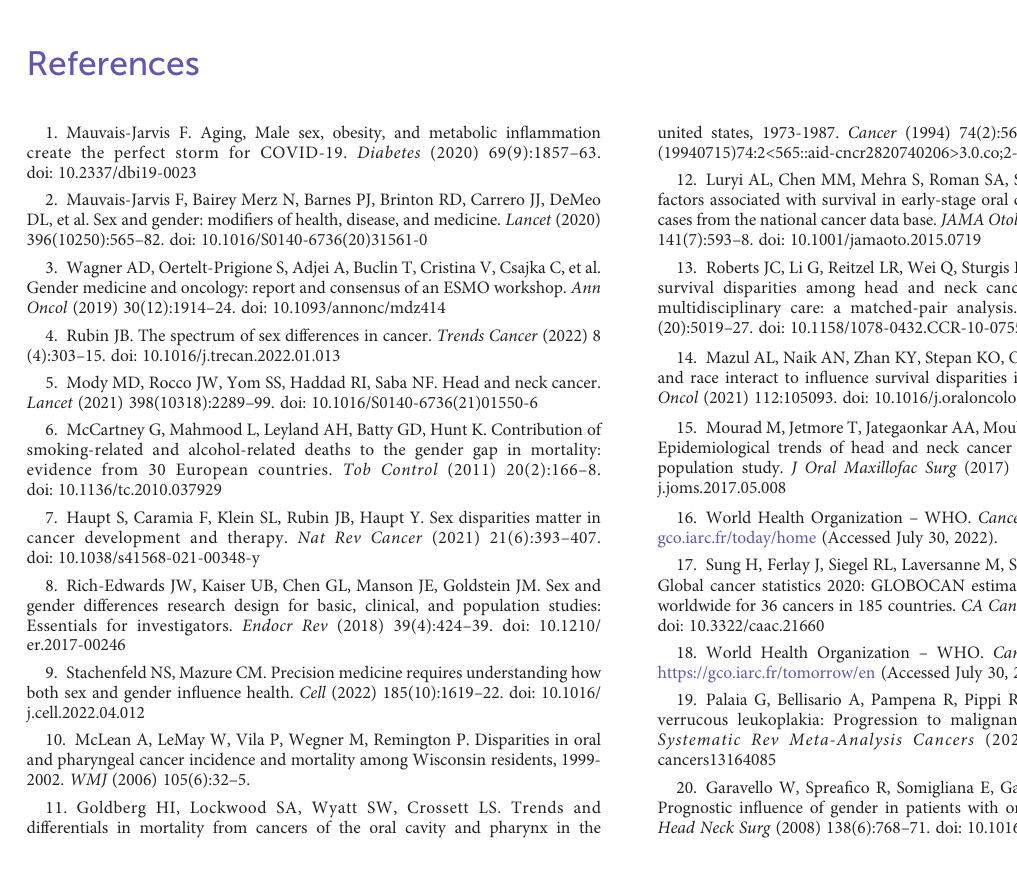
SUPPLEMENTARY TABLE 1 Failure events of the whole patients ’ cohort. SUPPLEMENTARY TABLE 2 Deaths and causes of the whole patients ’ cohort. SUPPLEMENTARY TABLE 3 Overall Survival (OS) for stage III-IV patients, multivariate